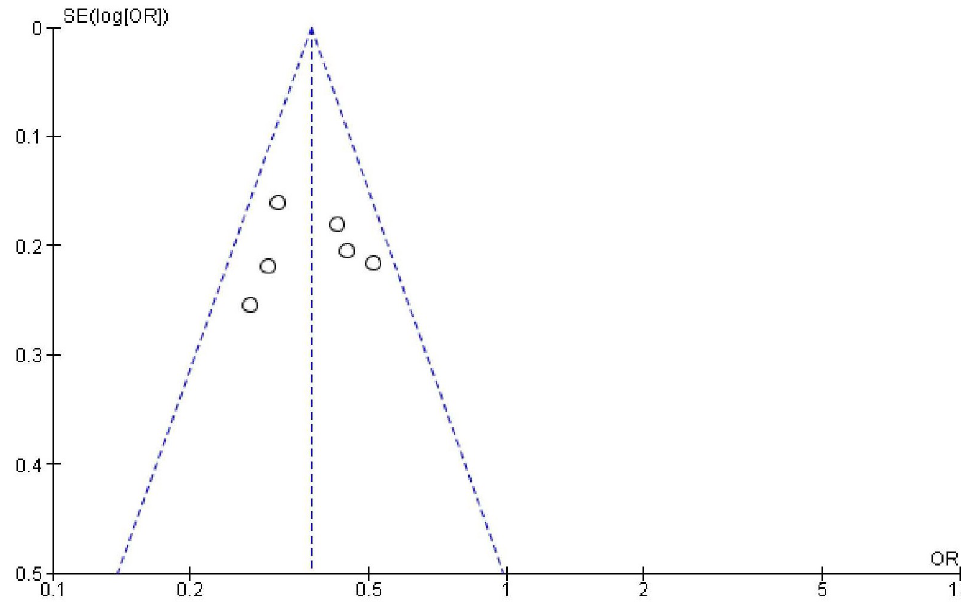
Fig 23. Publication bias on length of time after